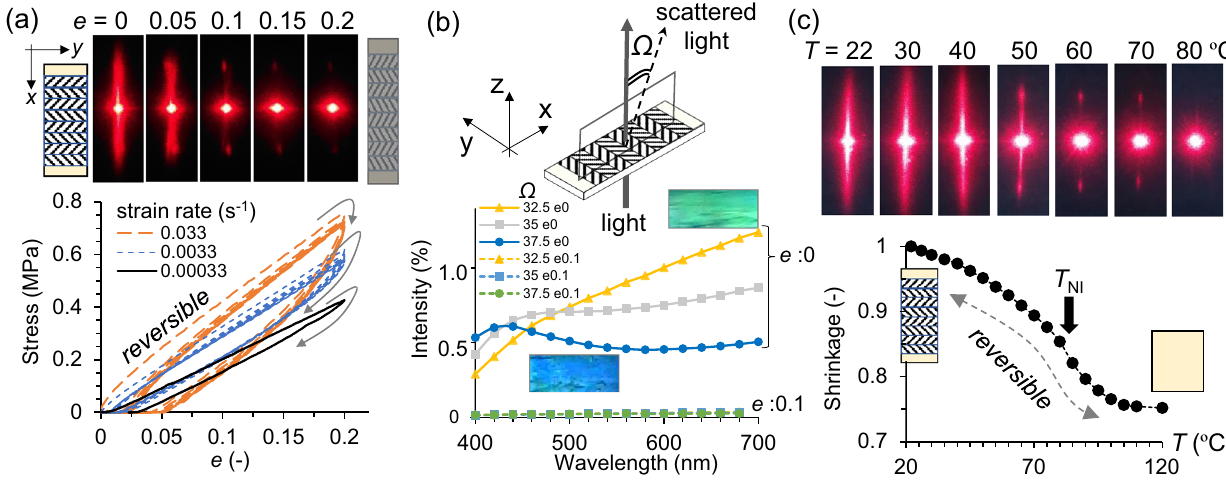
Fig. 5 Dynamic optical effects of LCEs with stabilized buckled director patterns. a LS patterns obtained at different applied uniaxial strains (top) and stress – strain curves acquired at different strain rates (bottom). The LS patterns are of the slowest strain rate. b Angle-dependent spectra of scattered light obtained with ( e = 0.1) and without strain ( e = 0). The insets show sample images with a sharp angle-dependency of colors (iridescence) at e = 0. c LS patterns obtained at different temperatures (top) and the corresponding temperature-dependent strain